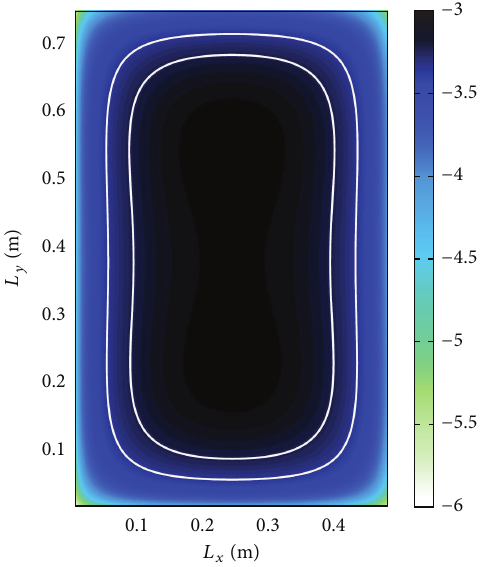
Figure 3: WSSG field for the clamped plate 1, 2 mode in dB, relative to the maximum value on the plate, at the 1, 2 mode natural frequency. The inner white line represents the 3 dB down contour and the outer one represents the 6dB